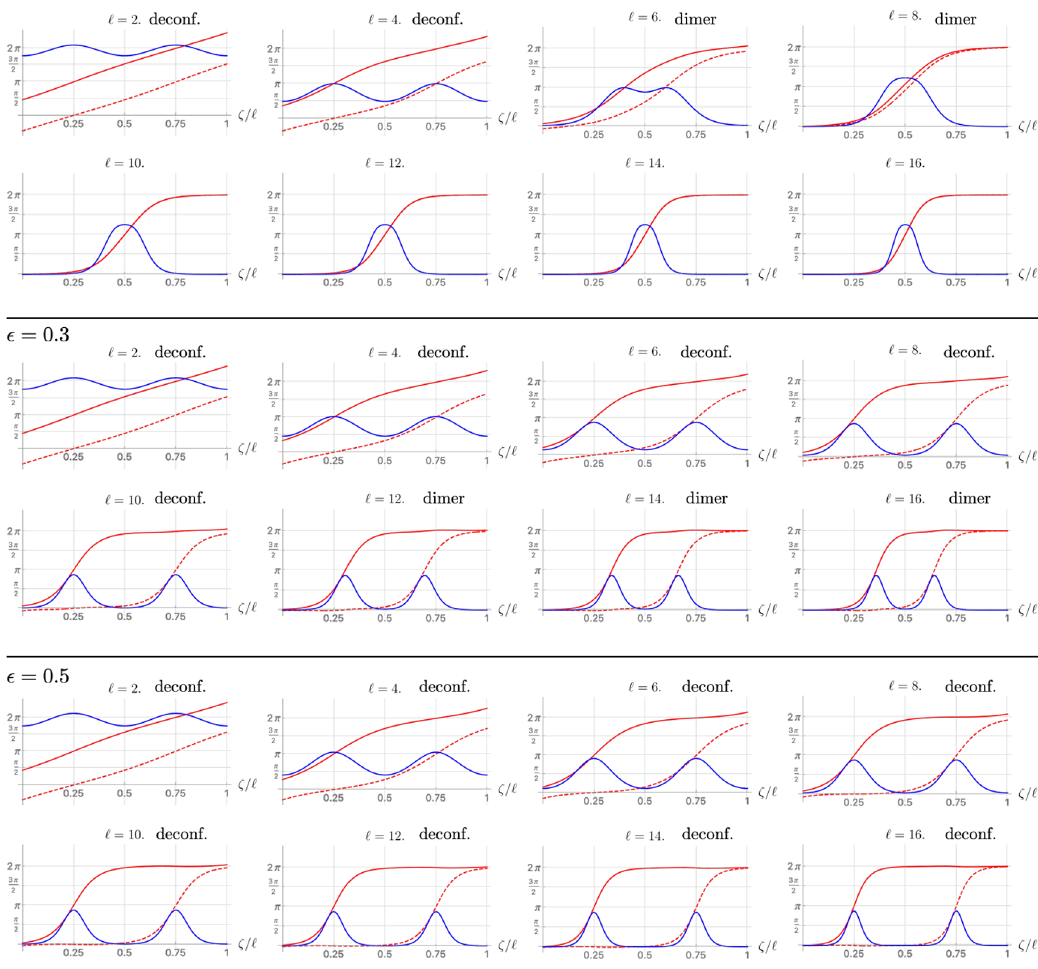
Figure 5 . The numerical solutions of CSLs with the fixed β = π/ 16 . The solutions in the top/middle/bottom row are for (cid:15) = 0.125/0.3/0.5, respectively. For each (cid:15) we show the CSL with the lattice space ‘ = 2 , 4 , 6 , 8 , 10 , 12 , 14 , 16 . The horizontal axes is normalized coordinate ζ/‘ , and the red-solid and red-dashed curves show φ + and φ − , respectively. The blue-solid curve correspond to the energy density. We put “deconf.” if the CSL is in the deconfinement phase, and “dimer” if it is in the dimer